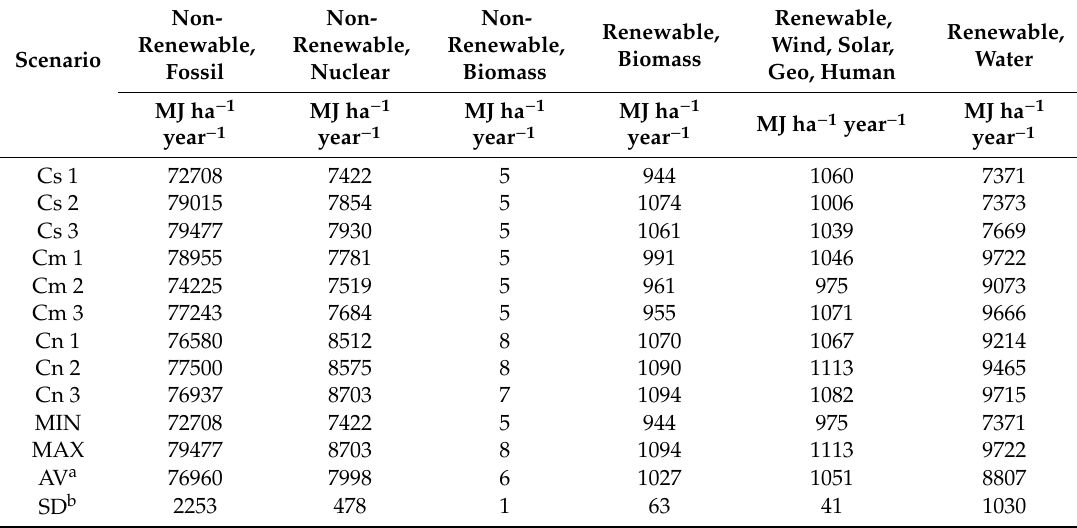
Table 5. Energy results in the conventional farming